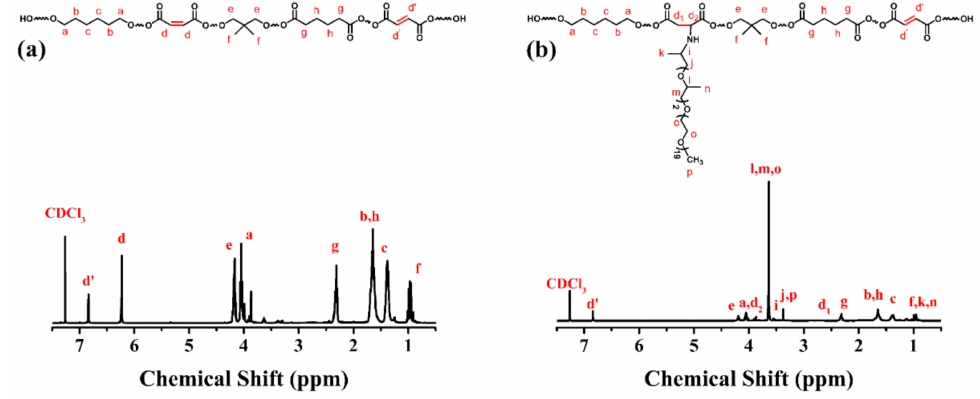
Figure 1. The 1 H NMR of linear polyester ( a ), and comb-like polyester ( b ). The FTIR spectrum and the second derivative spectrum of both Entry 3L and Entry 3C are shown in Figure 2. The broad absorption peak at 3545 cm − 1 is the stretching vibration peak of O − H, and the absorption peak at 3420 cm − 1 in the spectrum of comb-like polyester is the stretching vibration peak of N − H. The stretching vibration peaks of − CH 3 and − CH 2 appear at 2936 cm − 1 and 2862 cm − 1 , and the peak at 1459 cm − 1 belongs to − CH 3 and − CH 2 bending vibration. The difference of the peak at 1723 cm − 1 was amplified by the second derivative spectrum. The peak at 1740 cm − 1 belongs to the carbonyl ester C=O, which is attached to C − C bonds. The peak that appears at 1700 cm − 1 is ascribed to the carbonyl ester C=O attached to the C=C bonds. The two peaks at 1253 cm − 1 and 1102 cm − 1 belong to the asymmetric stretching vibration and symmetric stretching vibration of the carboxyl group C − O − C, respectively [30]. After the aza-Michael addition was accomplished, the ratio of the C − O − C peak intensity to the C=O peak absorption intensity increased, which indicated that the addition reaction was successful. The two peaks observed at 1640 cm − 1 and 976 cm − 1 are ascribed to the C=C tensile vibration and the trans C=C − H out-of-plane bending vibration, respectively. The peak intensity at 976 cm − 1 was enhanced after aza- Michael addition, which indicates that cis units reduced in the addition process.